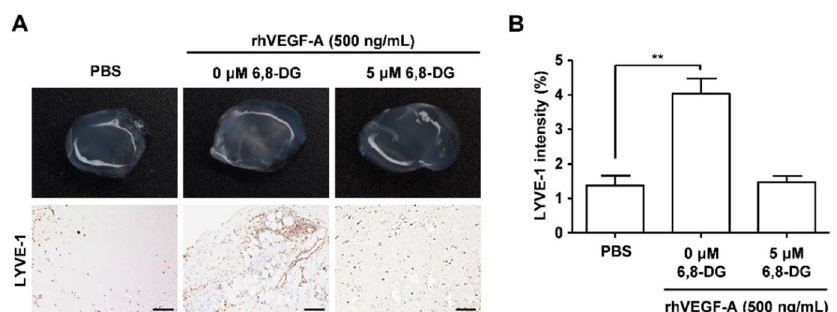
Figure 3. Effects of 6,8-DG on VEGF-A-induced lymphangiogenesis in an in vivo Matrigel plug. ( A ) Matrigel plugs were excised and photographed using a digital camera. The lymphatic vessel density values in Matrigel plug sections were measured using the immunohistochemical analysis with anti-LYVE-1 antibody. All Matrigel sections were digitalized and microscopic images were captured under 200× objective magnification. Scale bar = 200 μm. ( B ) Immunohistochemical inten- sity values (LYVE-1) from captured images were analyzed by the Image J program and repre- sented as a bar diagram. Data are presented as a mean ± S.D. (** p < 0.01).